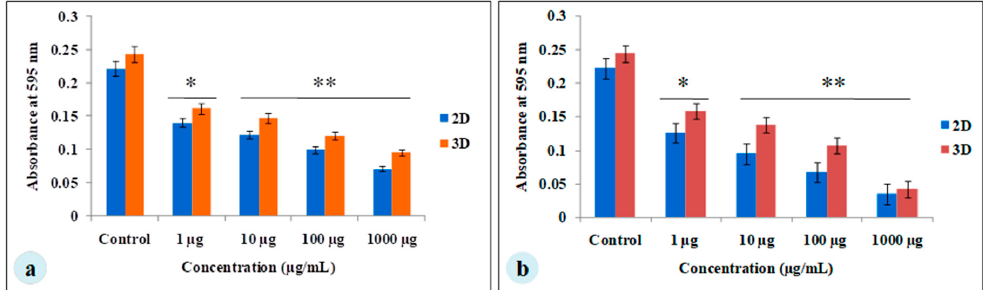
Figure 3. Viability of MDA-MB-231 cells treated with cyclosaplin and doxorubicin. The MDA-MB-231